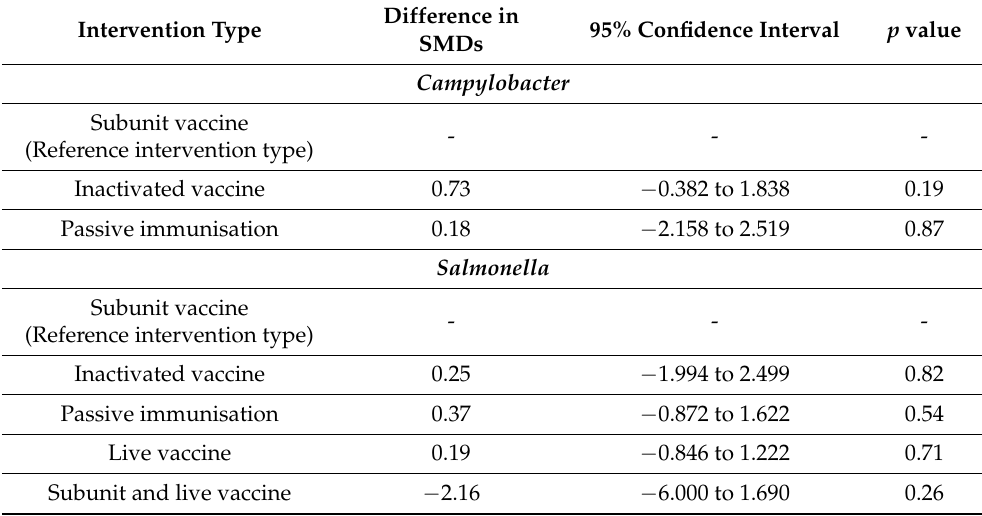
Table 5. Summarised results of the meta-regression for vaccinations against Campylobacter ( n = 25) and Salmonella ( n = 34) comparators subgrouped by vaccine or immunisation type. SMDs and p values are presented to 2 decimal places, and 95% CI’s are presented to 3 decimal